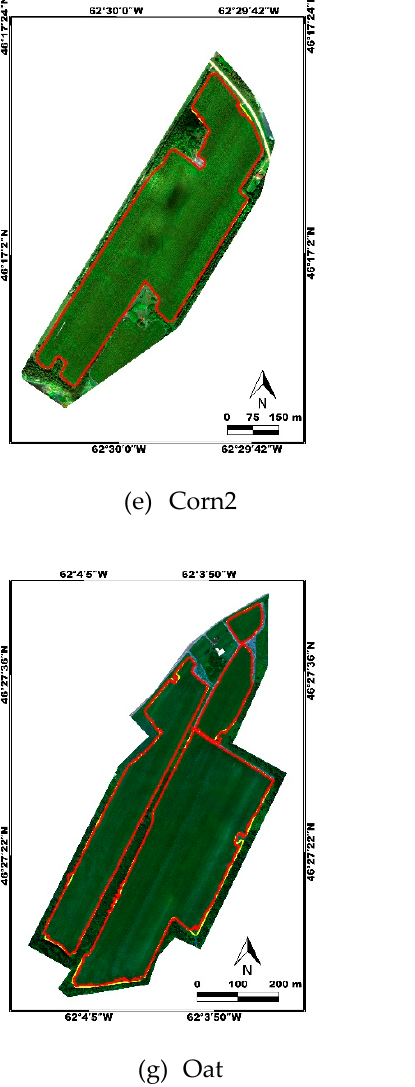
Figure 6. Red, green and blue (RGB) image composites comparing the manually-delineated and PBIA-delineated borders for the following fields: ( a ) Barley1, ( b ) Barley2, ( c ) Barley3, ( d ) Corn1, ( e ) Corn2, ( f ) Corn3, ( g ) Oat; ( h ) Legend. The manually delineated borders are represented in yellow. The machine delineated borders are represented in red.